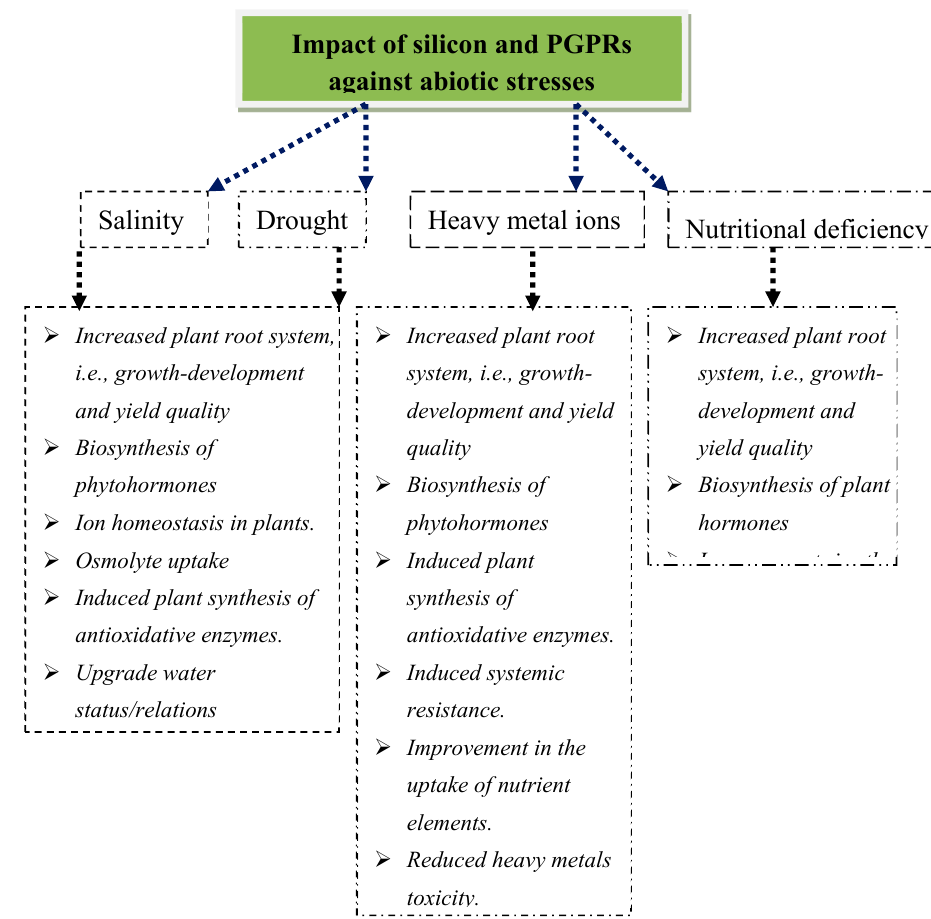
Figure 1. The multiple functions of silicon and plant growth promoting rhizobacteria (PGPRs) alleviate abiotic stresses in plants [17,29,36–44].